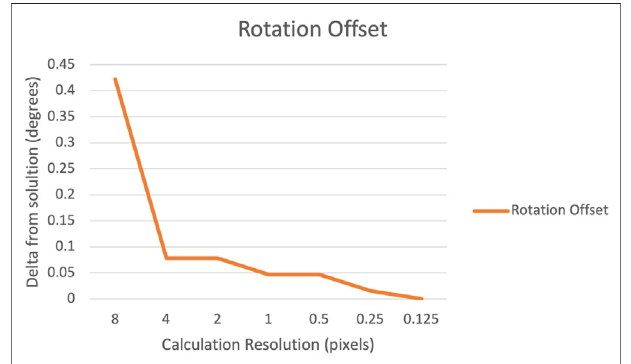
FIGURE7| Chartdemonstratesthesoftwareconvergingonthesolution of the x and y centroid offsets as the resolution of each pass increases.